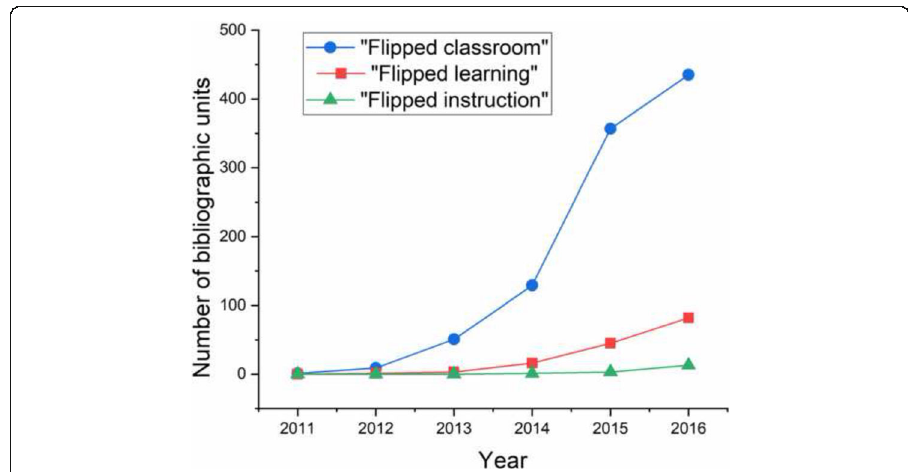
Fig. 1 The literature trend. Annually published number of scholarly, peer-reviewed journal articles containing the phrases “ flipped classroom, ” “ flipped learning, ” or “ flipped instruction ” in the 2011 – 2016 period